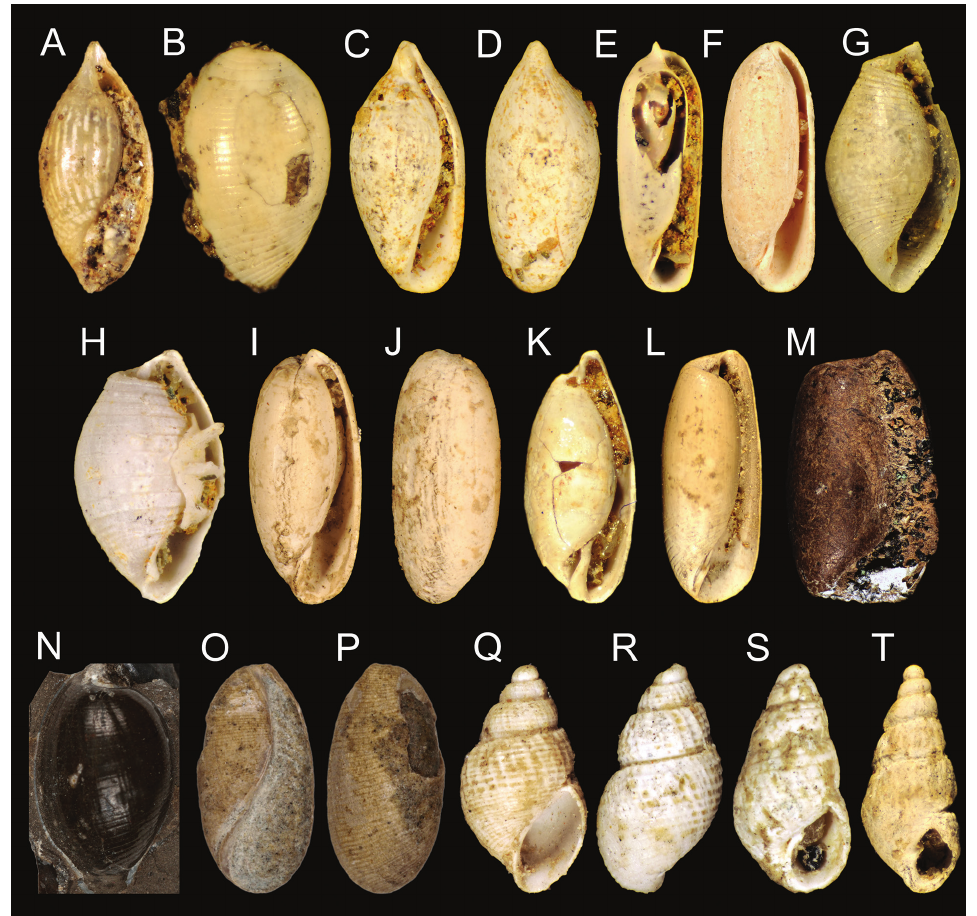
Figure 6. Types. A. Holotype of Volvulella micratracta , H 1.5 mm, ANSP IP3842. B. Syntype of Volvulella minutissima new comb., H 2.3 mm, ANSP IP13267. C–D. Holotype of Volvulella ornata , H 3.2 mm, ANSP IP3178. E. Holotype of Volvulella parallela , H 2.1 mm, ANSP IP3188. F. Holotype of Volvulella tritica , H 4.1 mm, ANSP IP19104. G. Holotype of Atys cinctorii , H 2.6 mm, ANSP IP3185. H. Syntype of Atys sulculorum , H 2.5 mm, ANSP IP3317. I–J. Syntype of Cylichna cylindrus , H 4.7 mm, ANSP IP1554. K. Syntype of Cylichna dekayi , H 5.0 mm, ANSP IP6008. L. Syntype of Cylichna kellogii , H 5.7 mm, ANSP IP13266. M. Holotype of Cylichna recta , H 8.0 mm, ANSP IP18782. N. Syntype of Bulla occidentalis , H 10.0 mm, ANSP